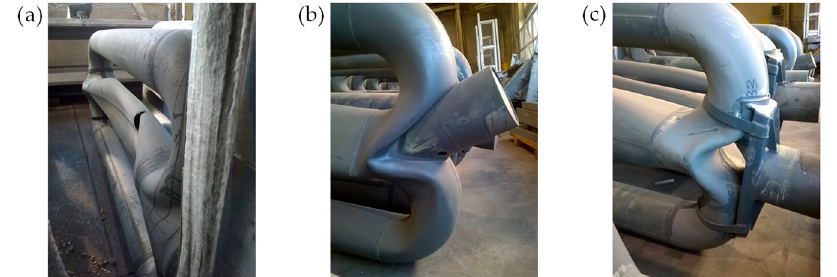
Figure 1. Damaged double-P-type radiant tubes with a ruptured tube ( a ), deformed support ( b ), and deformations with an alternative support design ( c ).